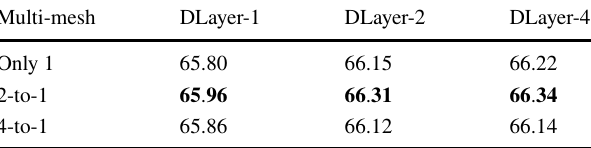
Fig. 6 Details of the accuracy of the model with different levels of multi-level question features and different numbers of decoding lay- ers. There are three types of questions: binary choice questions “Yes/ No”, counting reasoning questions “Num” and other types of reason- Table 4 Results of models with different levels of multi-level ques- tion features and different numbers of decoding layers on the VQA v2 val dataset